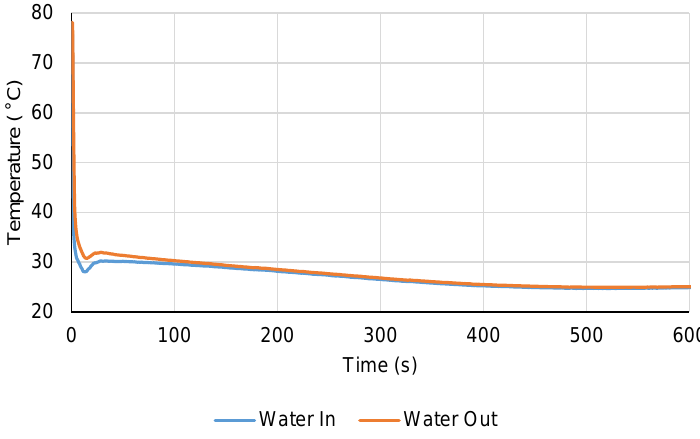
Energies 2021 , 14 , x FOR PEER REVIEW Figure 11. Inlet and outlet water temperature during the LTJ adsorption test. Figure 11. Inlet and outlet water temperature during the LTJ adsorption test.